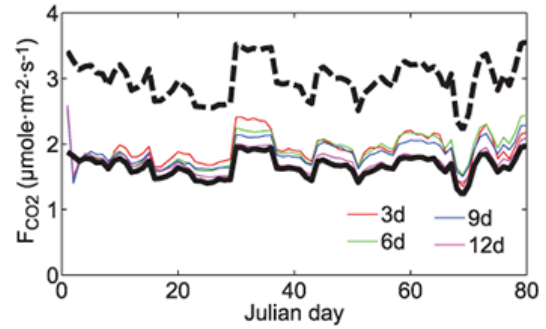
Figure 13. Time series of daily mean CO 2 fluxes averaged in do- main I (shown in Fig. 9a) from 1 January to 20 March 2010 with different smoother windows (3, 6, 9 and 12 days). The black dashed line is the time series averaged from F ∗ t and the black solid line is the time series averaged from F p t .